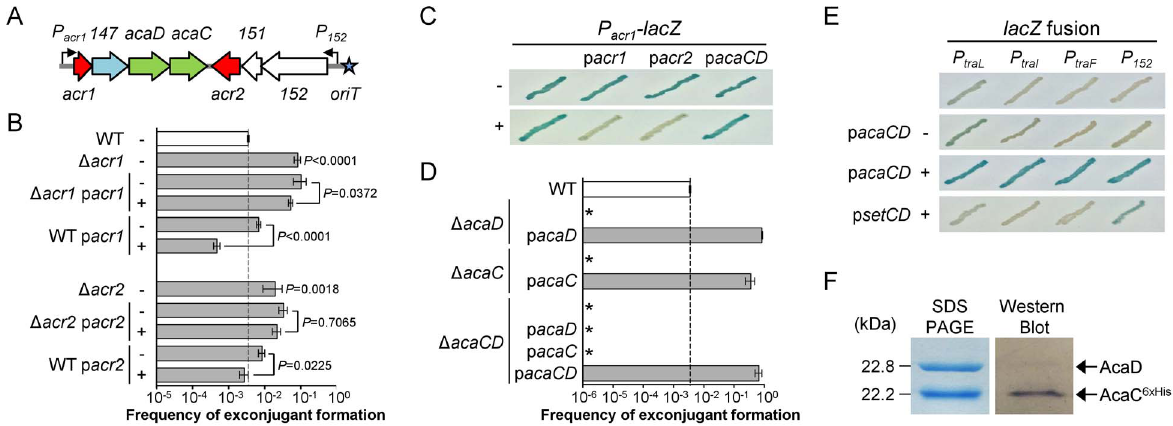
Figure 1. Regulation of IncA/C plasmids. (A) Schematic representation of the regulatory region of IncA/C plasmids. Genes and promoters are represented by arrowed boxes and angled arrows, respectively. Repressors and activators are shown in red and green, respectively. Genes of unknown function are shown in white and the gene coding for a putative lytic transglycosylase is shown in light blue. Locus names vcrxXXX are abbreviated as XXX . The oriT locus is depicted by a blue star. (B) Effect of the deletion and the overexpression of the negative transcriptional regulator-encoding genes acr1 and acr2 . Conjugation assays were carried out using as donors E. coli BW25113 Nx containing pVCR94 D X2 (WT) or its D acr1 and D acr2 mutants. Complementation and overexpression assays were performed with ( + ) or without ( 2 ) arabinose for the expression of acr1 (p acr1 ) or acr2 (p acr2 ) from the inducible P BAD promoter. E. coli MG1655 Rf was used as the recipient. Transfer frequencies are expressed as a number of exconjugant per recipient CFUs. The bars represent the mean and standard deviation values obtained from at least three independent experiments. Statistical analyses were performed on the logarithm value of the means using one-way ANOVA with Tukey’s multiple comparison test. P -values are indicated next to the bars when comparison referred to WT or next to the brackets when comparing two bars. (C) The constitutive promoter of acr1 ( P acr1 ) is repressed by Acr1 and Acr2. Activity of P acr1 was monitored from a single-copy, chromosomally integrated lacZ transcriptional fusion ( P acr1 - lacZ ). Colorimetric assays were carried out on LB medium supplemented with 40 m g/ml of X-Gal and induction with ( + ) or without ( 2 ) arabinose to express acr1 , acr2 or acaCD from P BAD on p acr1 , p acr2 or p acaCD , respectively. (D) AcaC and AcaD are essential for conjugative transfer. Transfer assays were carried out using E. coli BW25113 Nx containing pVCR94 D X2 (WT) or the mutants D acaC , D acaD or D acaCD . Complementation assays were performed by expressing acaC , acaD or acaCD from P BAD on p acaC , p acaD and p acaCD , respectively. Recipient strains and statistical analyses were as described for panel B. All P -values are below 0.0001 when compared to the WT. The asterisk indicates that frequency of exconjugant formation was below the detection limit ( , 10 2 8 ). (E) AcaCD is the direct activator of tra gene promoters. Activity of the P traL , P traI , P traF and P 152 was monitored from single-copy, chromosomally integrated lacZ transcriptional fusions. Colorimetric assays were performed as described in panel C with expression of acaCD or setCD from P BAD on p acaCD or p setCD (pGG2B), respectively. (F) AcaD co-purifies with AcaC. Coomassie blue- stained SDS-PAGE and Western blot analysis of AcaC purified using a Ni-NTA affinity chromatography. AcaD and 6 6 His-tagged AcaC were co- expressed in E. coli BL21(DE3) from p acaDC 6 6 His . Western blot analysis was performed using a monoclonal antibody against the 6 6